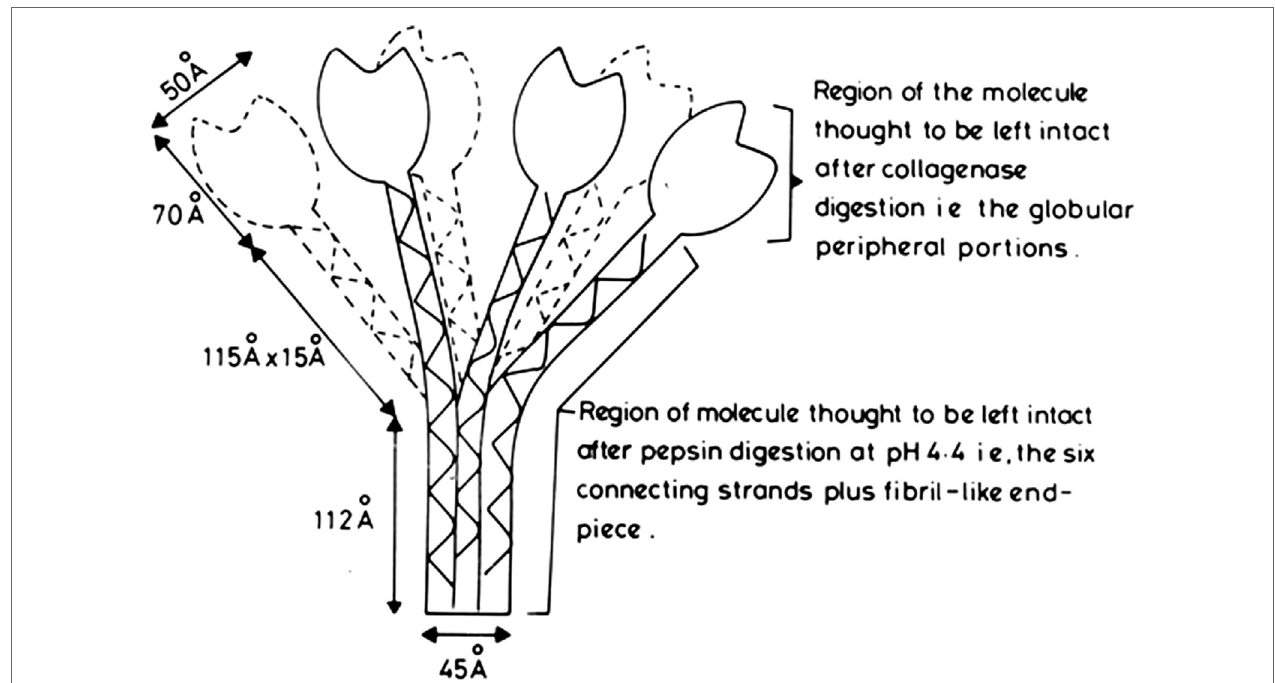
FiGUre 1 | Proposed model of human subcomponent C1q. Initial diagram, drawn up in 1975, of the first published molecular model proposed for C1q (14). It was based on the electron microscopy measurements (12, 13), the amino acid sequencing and physical chemistry results of the studies on the 190 kDa pepsin-resistant fragment of C1q (1, 11), and the assumption that the collagen-like regions in the A-, B-, and C-chains of C1q form a triple helical collagen-type structure (denoted by the solid, broken, and wavy lines), and the C-terminal approximately 140 amino acid residues, in each of the A-, B-, and C-chains, form a globular heterotrimeric structure of 47.8 kDa (which should, more correctly, be shown as globular units, rather than the tulip-flower shapes as shown in the initial diagram). From the dimensions shown, which are averages of those given in the electron microscopy studies (12), the following comparisons can be made: length of collagen-like fiber plus fibril-like end piece = 115 + 112 = 227 Å. Length of triple helix proposed from amino acid sequences = 78 × 2.9 = 226 Å (2.9 Å is the rise of collagen helix per residue, and there are 78 residues, over the collagen-like regions, in each of the three chains of